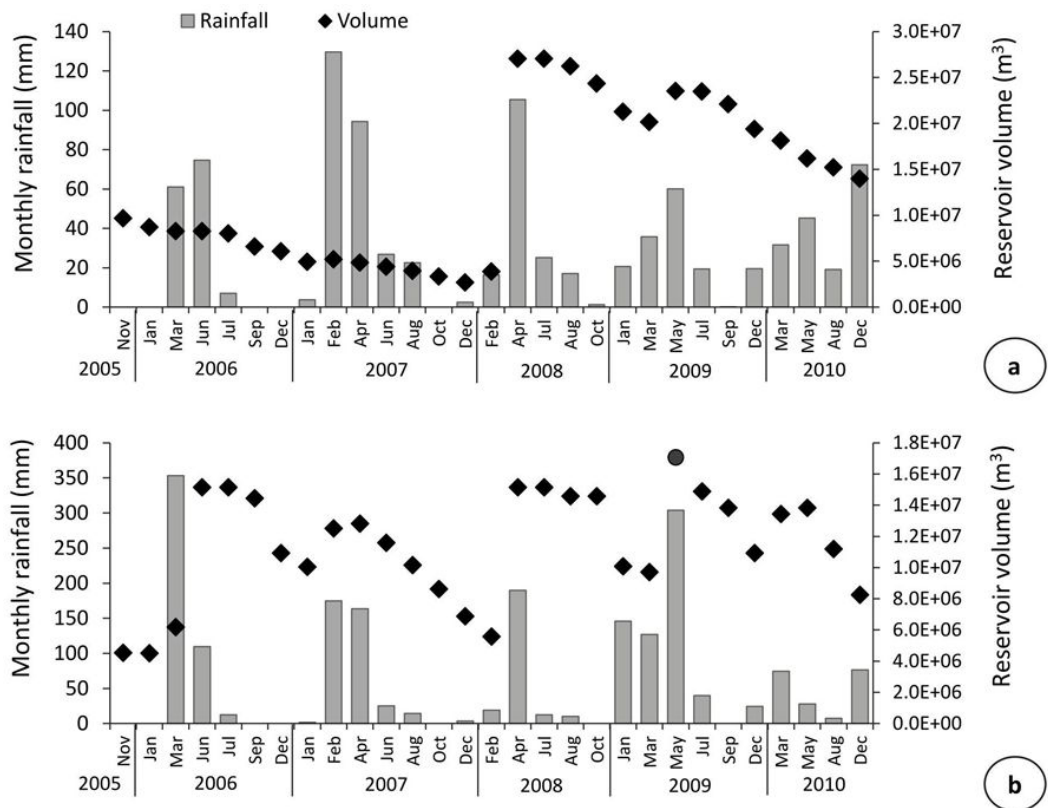
Figure 2. (a) Total accumulated rainfall in Soledade municipality and volume of water stored in Soledade reservoir; (b) total accumulated rainfall in Taperoá municipality and volume of water stored in Taperoá reservoir. The circle symbol in the volume of the Taperoá reservoir indicates overflow of